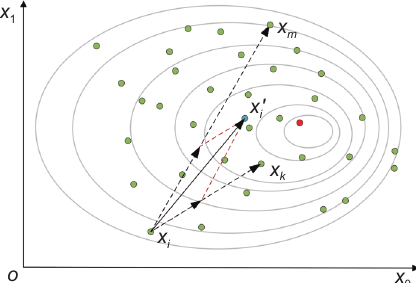
Fig. 3 Illustrations of Manhattan distance based learning